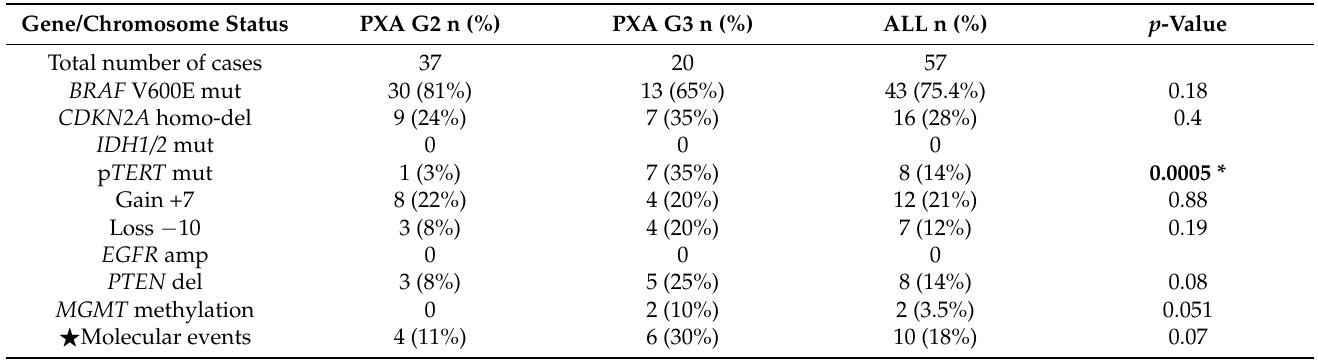
Table 3. Molecular characteristics of the cases of PXA.